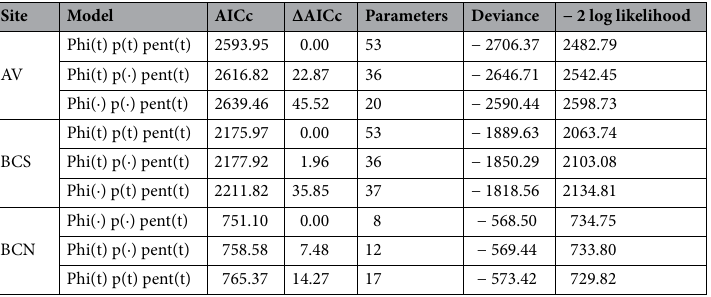
Table 2. Rankings of the top three mark-recapture models for each study site. For each site a set of models was constructed in which the three parameters (survival (phi), recapture (p) and entry (pent)) were held constant over time (·) or allowed to vary over time (t). Abundance estimates were obtained from the top-ranked model for each site. At both Anse Vata (AV) and the Baie des Citrons south (BCS) the top-ranked model was one in which all three parameters varied over time (Phi(t) p(t) pent(t)). At the Baie des Citrons north (BCN) = the best model was one in which survival and recapture were constant over time but entry varied annually (Phi(·) p(·) pent